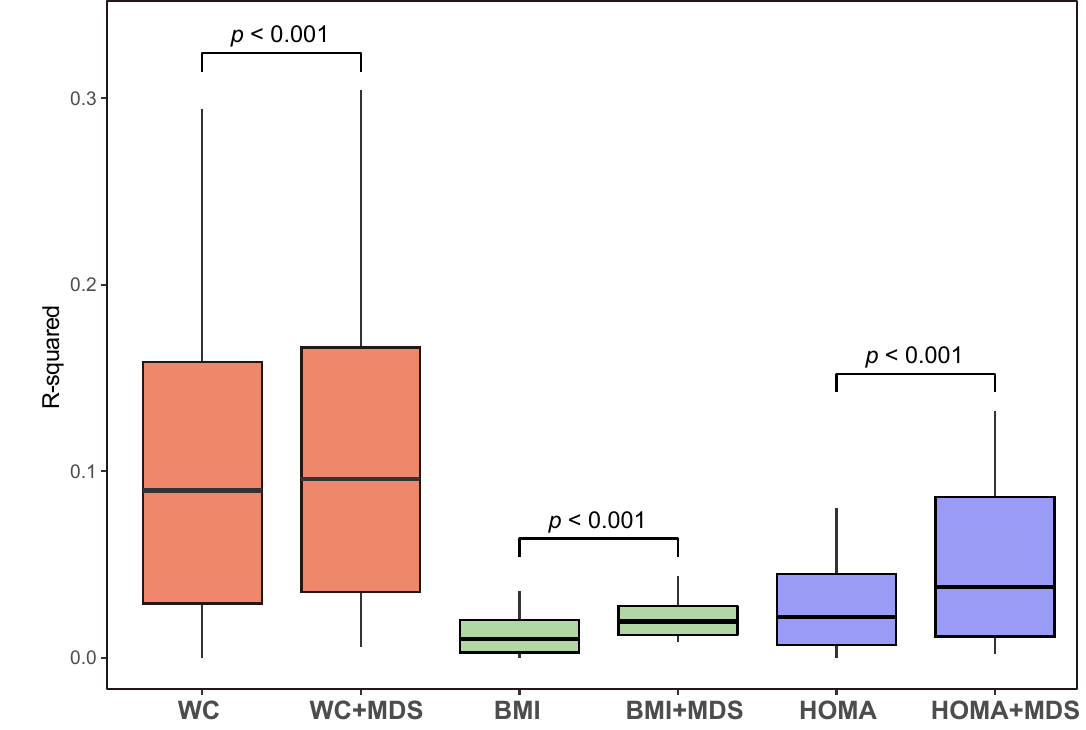
Figure 2. Proportions of variance in miRNA expression (R2) explained by WC, BMI, and HOMA-IR respectively and in combination with MDS scores. MiRNA, micro RNA; WC, waist circumference; BMI, body mass index; HOMA-IR, homeostasis model assessment of insulin resistance; and MDS, Mediterranean diet